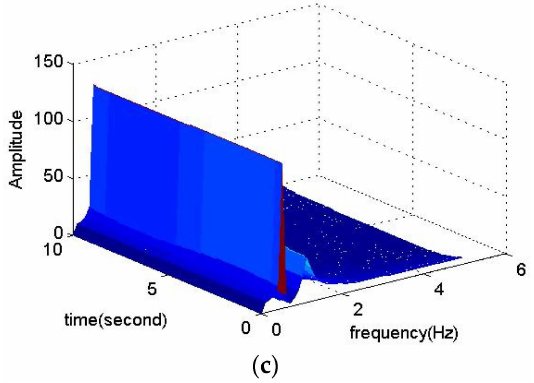
Figure 7. Full band time-frequency distribution analysis by FSWT. ( a ) Fourier spectrum; ( b ) The 2D maps of FSWT coefficients; ( c ) The 3D maps of FSWT coefficients.